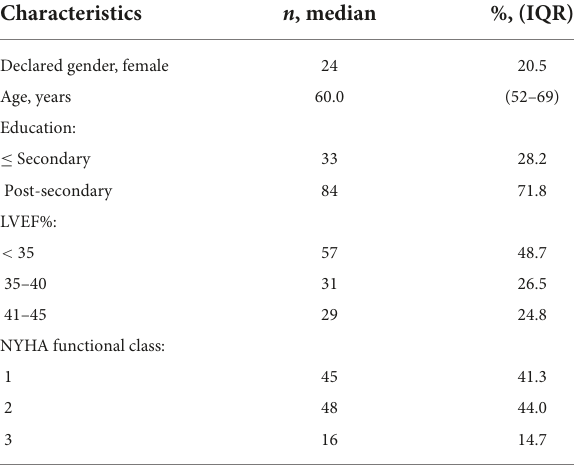
TABLE 1 Background characteristics of e-Counseling + usual care arm of CHF-CePPORT trial ( n = 117). Characteristics